Question: What style of plot is this figure drawn as?
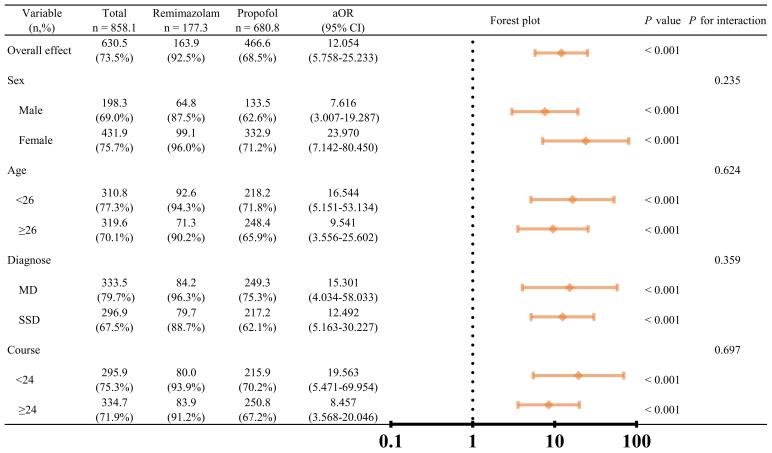
Answer: forest